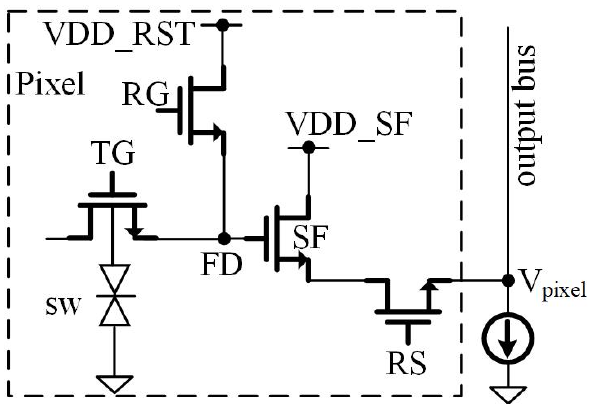
Figure 2. Diagram of the pump-gate jot.